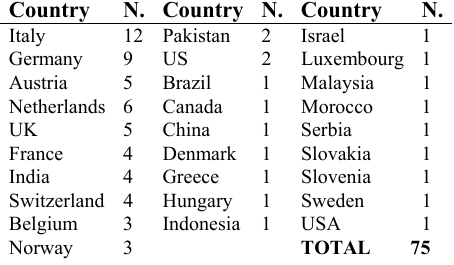
Table 1. Country distribution of applicants. Country N. Country N. Country